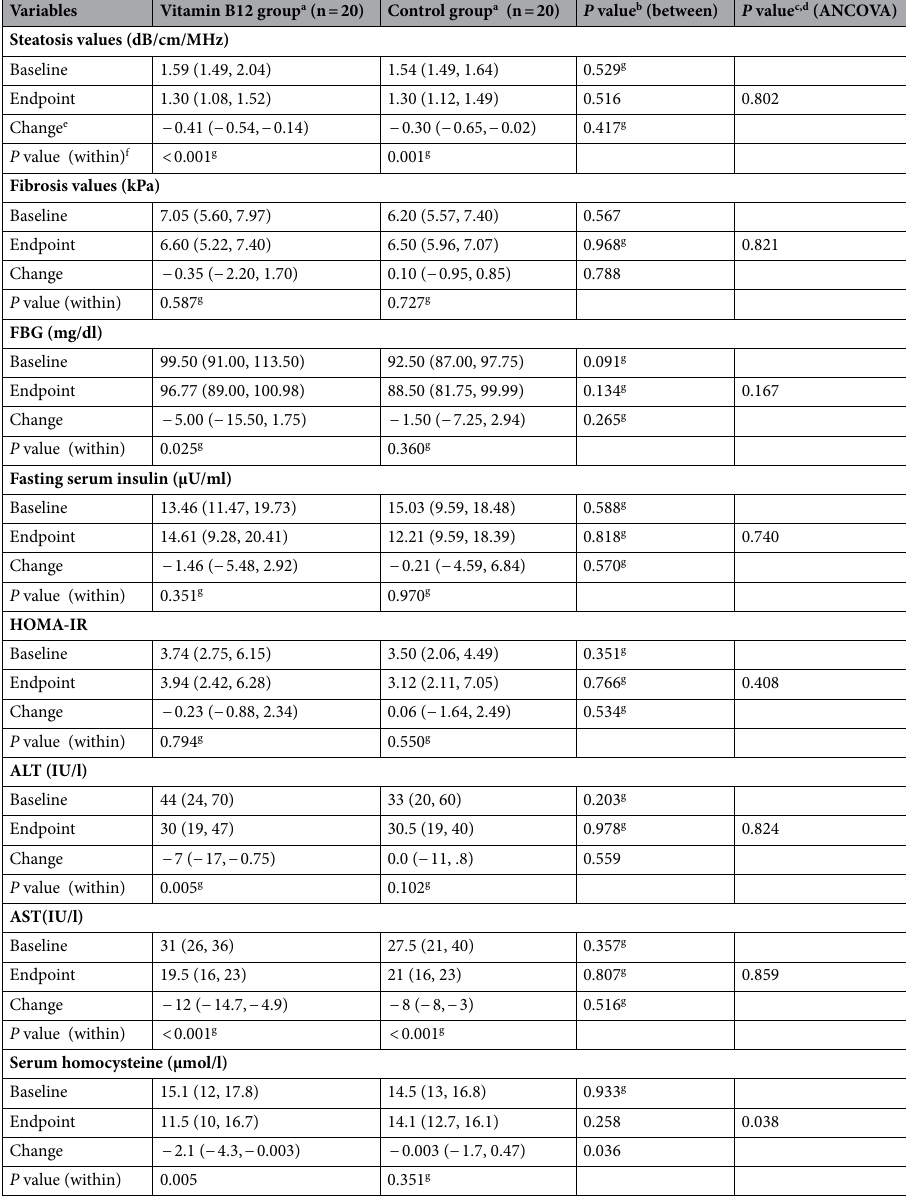
Table 3. Within-group and between-group comparisons of the baseline, endpoint and changes’ values for the study primary outcomes in vitamin B12 and placebo groups. ALT alanin transaminase, ANCOVA analysis of covariance, AST aspartate transaminase, FBG fasting blood glucose; HOMA-IR homeostatic model assessment of insulin resistance. a Values are expressed as mean ± standard or median (25th, 75th percentiles). b P -value for comparing the values between the study groups at baseline, at the endpoint and the change from baseline. Two sample t-test and Mann–Whitney U test were used for parametric and non-parametric comparisons, respectively. c P value for ANCOVA test to determine the significant levels of differences between the two groups post-intervention while adjusting for baseline measurements and covariates. d Adjusted for baseline values of corresponding variable, age, and the baseline values of FBG. e Endpoint values minus the baseline ones. f P -value for comparing baseline with end point values within each group. Paired sample t-test and Wilcoxon Paired Rank test were used for parametric and non-parametric comparison, respectively. g P -value obtained from a non-parametric